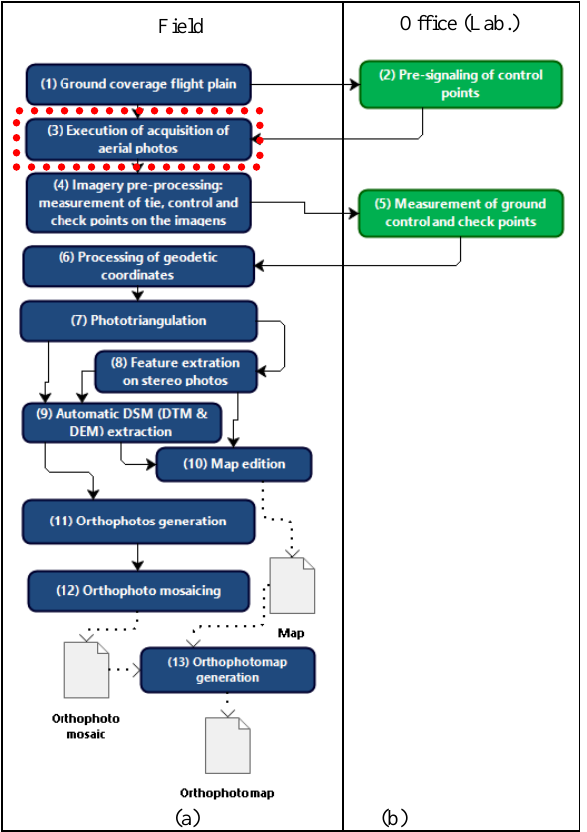
Figure 1. Photogrammetric process flow: (a) Office; (b) Field. In highlight the step that was not possible to execute without RPAS in